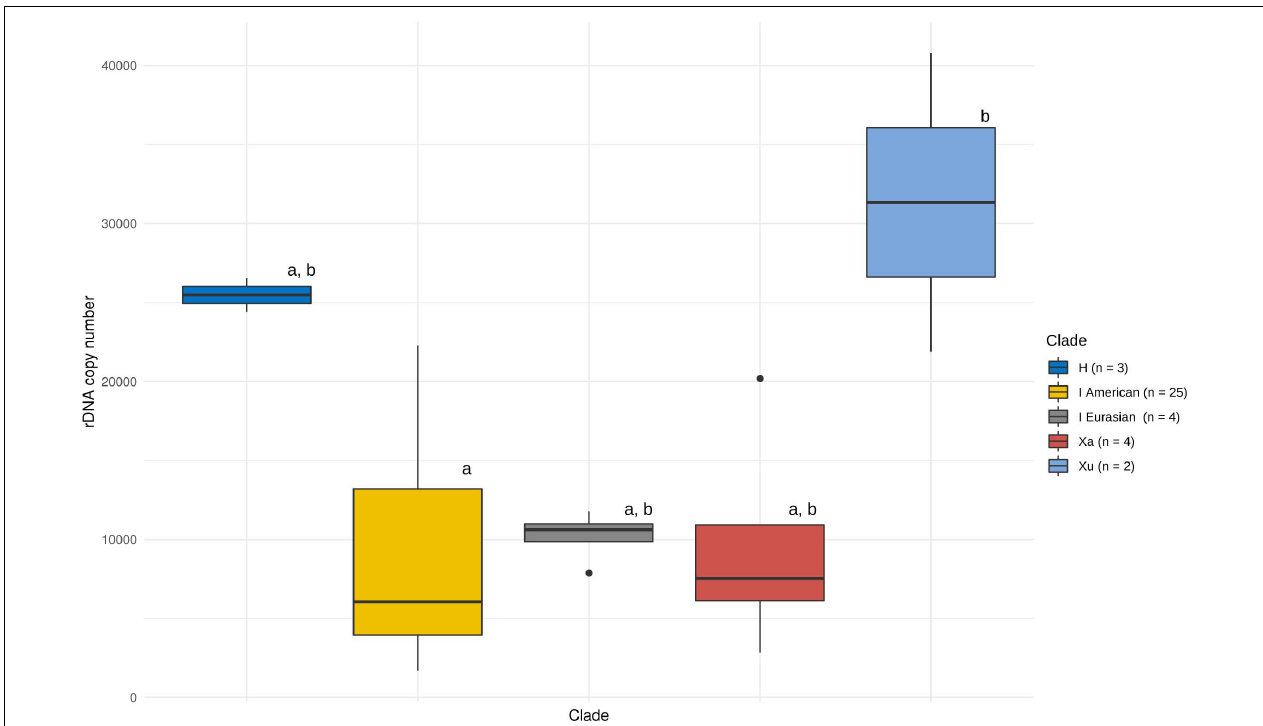
FIGURE 1 | Copy number variation of the native ribotype in Hordeum . Variation within and between major phylogenetic groups is shown. The boxes represent the range between 25th and 75th percentil. The whiskers represent the distance between hinges to the 1.5 × IQR (IQR is the inter-quartile range, or distance between the first and third quartiles) to both sides (toward the maximum as well as minimum values). Vertical bars represent the median values and outlayers are dispalyed as individual points. Phylogenetic grouping is based on Brassac and Blattner (2015). Differences among means (solid lines in boxes) at P = 0.05 (as analysed by ANOVA) are indicated by letters above boxes (boxes with the same letters are not significantly